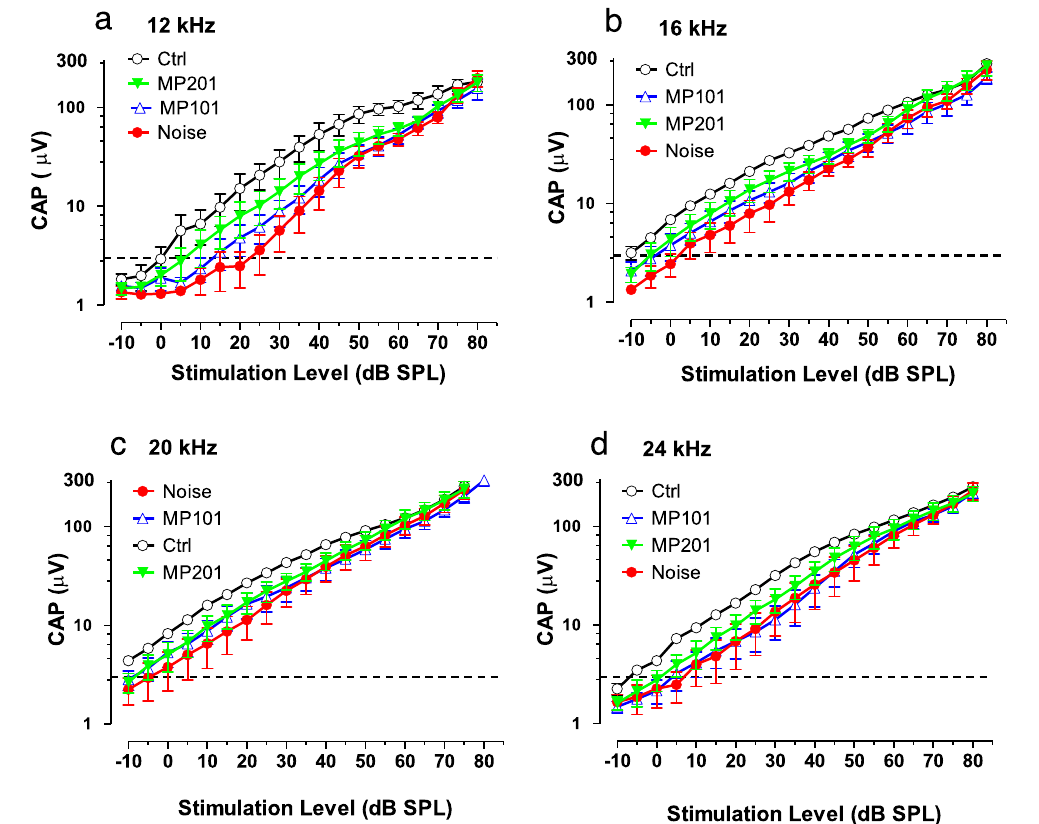
Figure 6. MP101 and MP201 are protective for hearing loss due to noise trauma. The compound action potential (CAP) amplitude is plotted on a logarithmic on the y -axis with the intensity of noise (decibels) on the x -axis. The CAP input/output functions are shown at ( a ) 12, ( b ) 16, ( c ) 20 and ( d ) 24 kHz. The data indicate that the CAP amplitudes were larger (better) in the noise-exposed groups that received MP201, versus the Noise alone group and statistically significant at 16, 20 and 24 kHz ( p -value < 0.0001), but not 12 kHz (unpublished). Repeat measures by ANOVA.